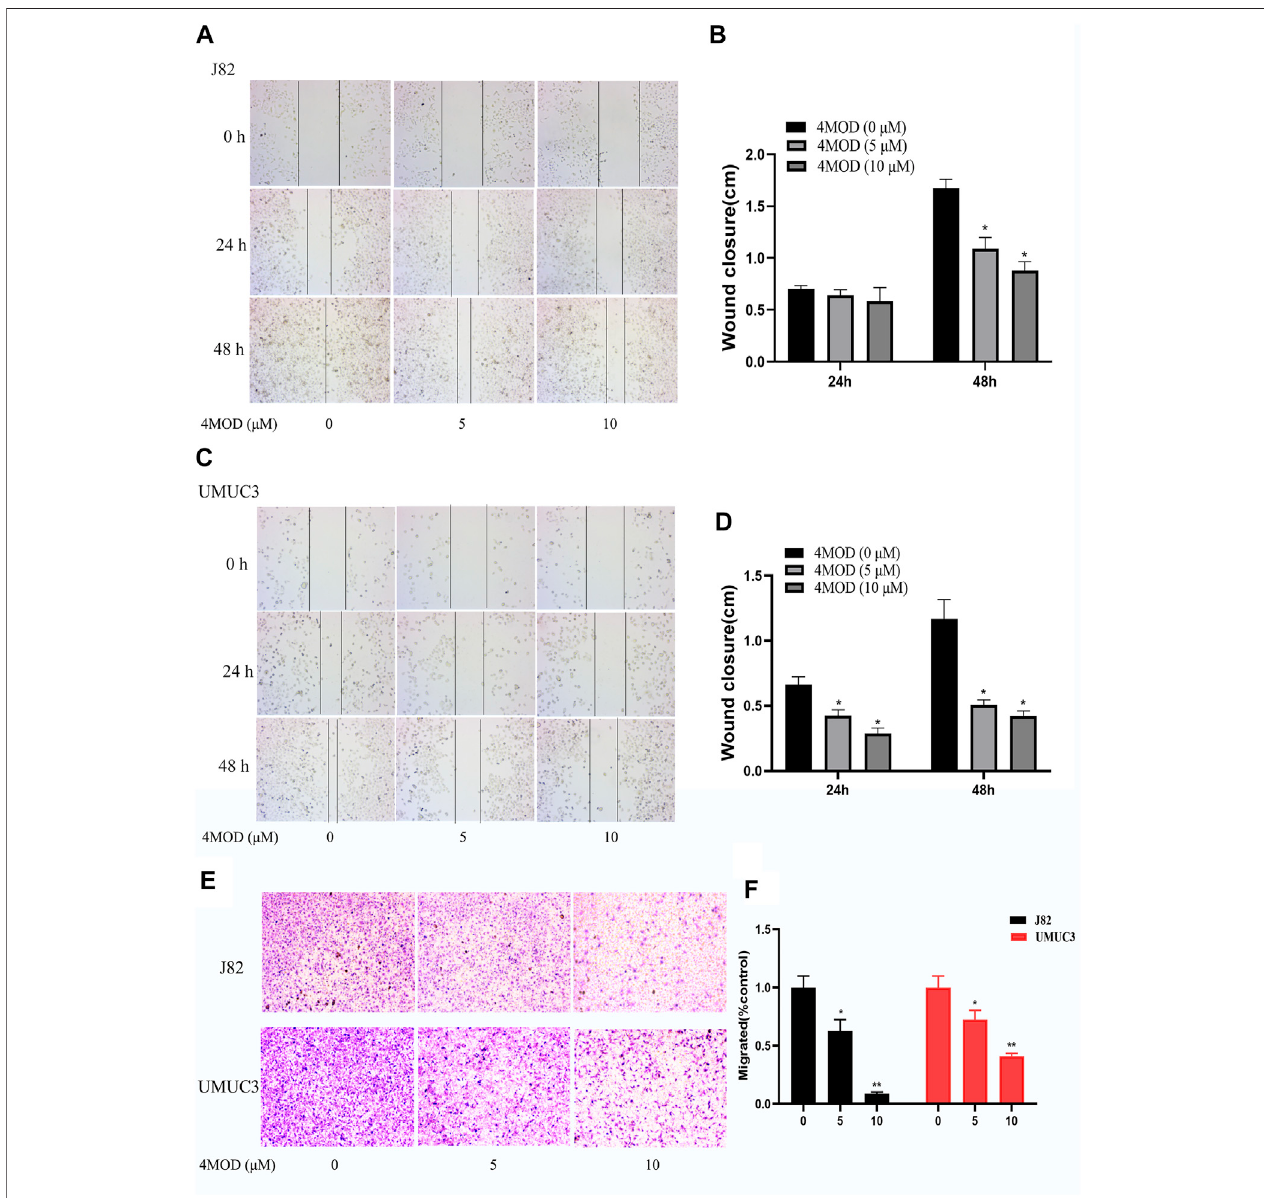
FIGURE2 | 4MOD represses invasion and migration ofBC cells (A – D) Transwell assayon the human BC cell lines UMUC3and J82 treated with 4MOD (0 μ M, 5.0 and 10 μ M)) for 48 h (E – F) The migration was measured by wound healing assays in the different group of cells; Data are presented as mean ± SD of 3 independent wound healing assays experiments (* p < 0.05, ** p < 0.01 compared with control).